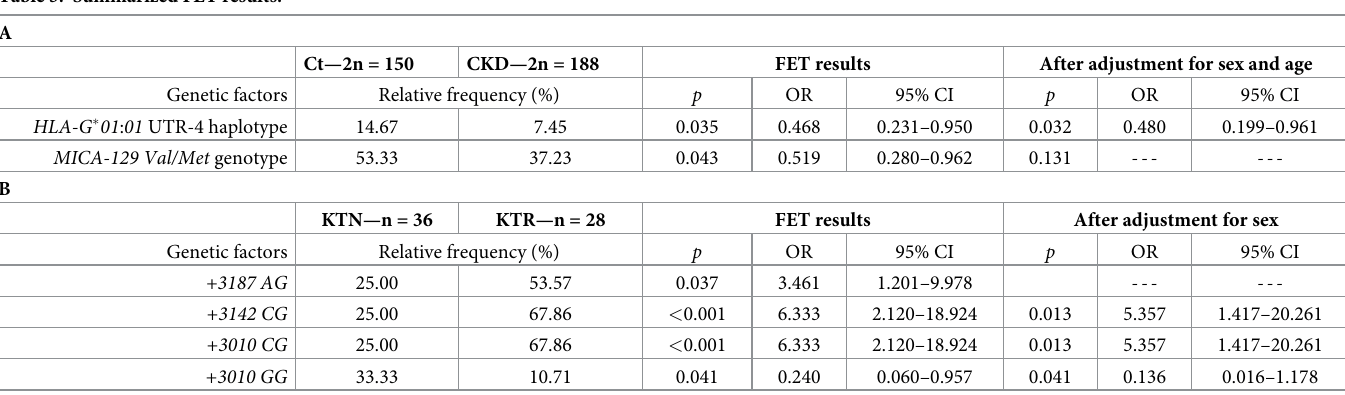
Table 3. Summarized FET